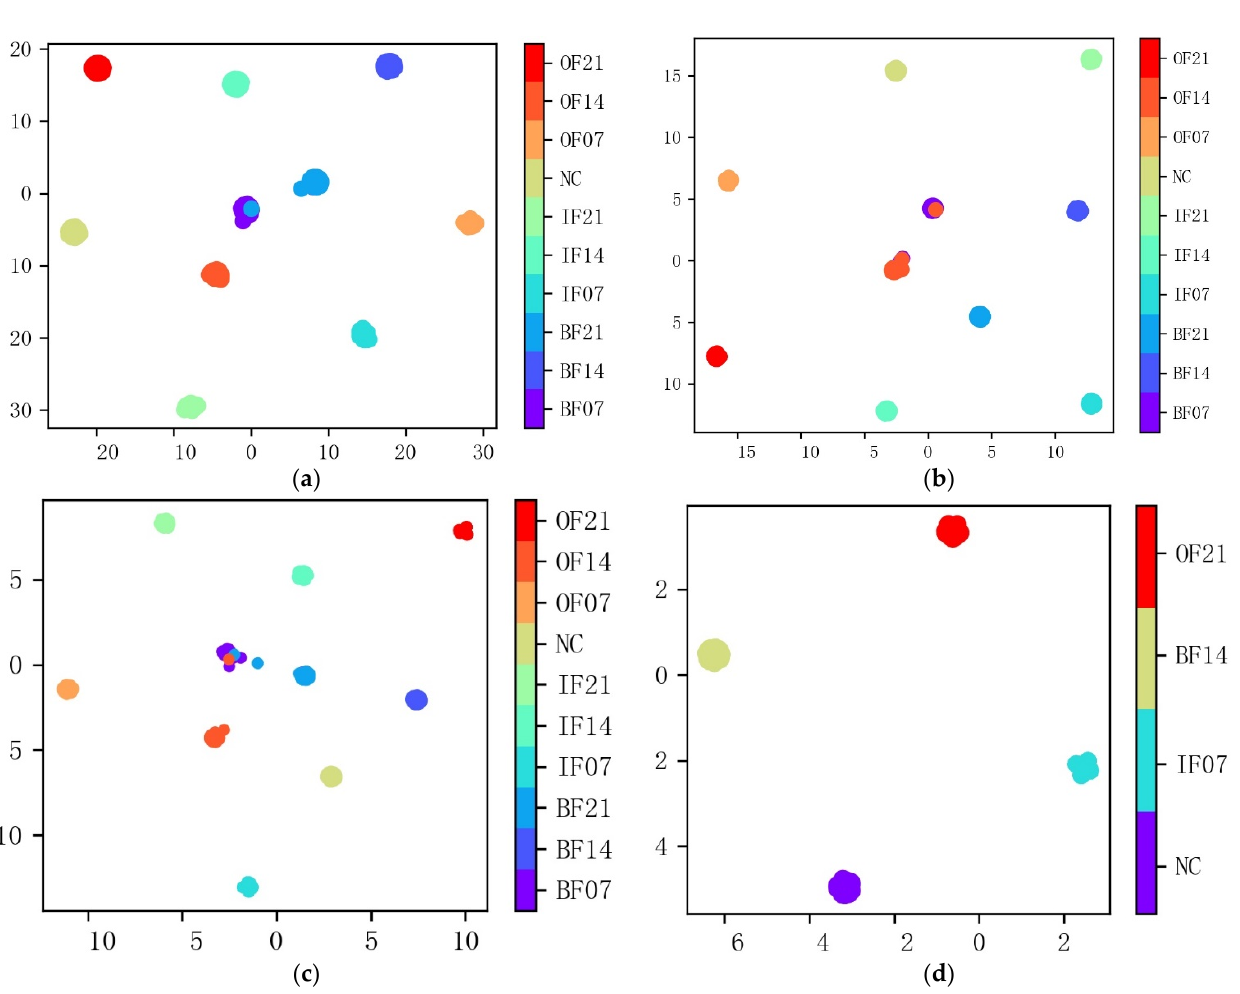
Figure 7. Confusion matrixes for each dataset: ( a ) Dataset A; ( b ) Dataset B; ( c ) Dataset C; ( d ) Dataset D.